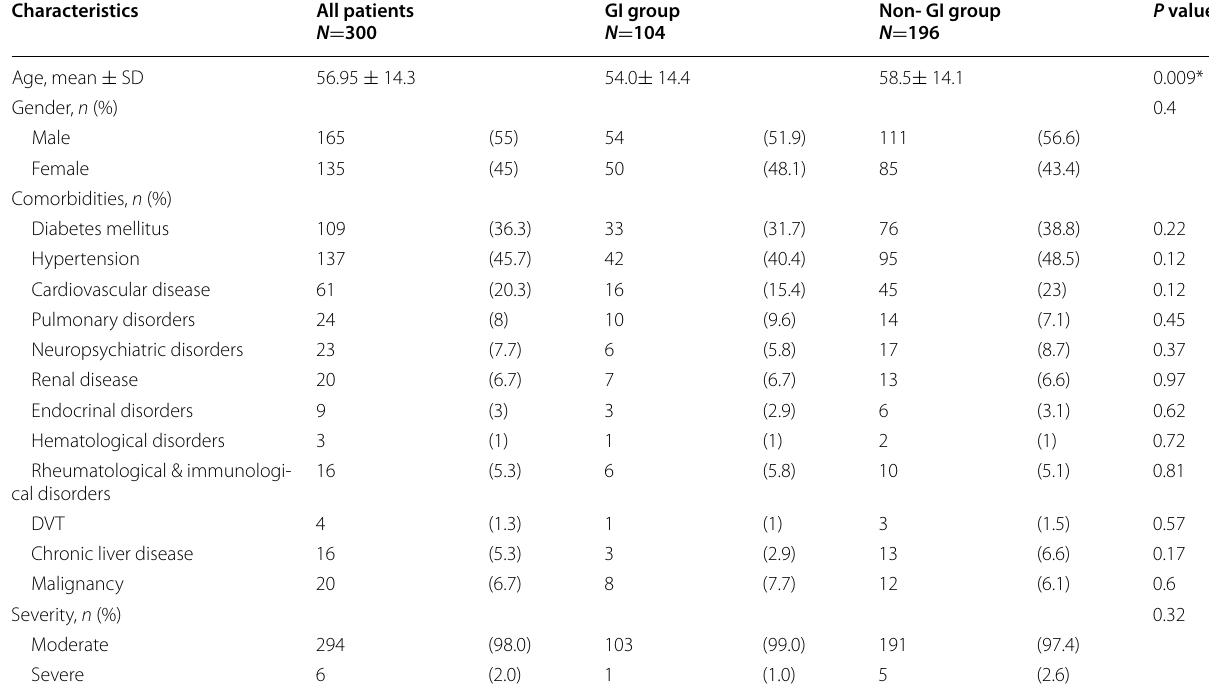
Table 1 Demographics of patients with